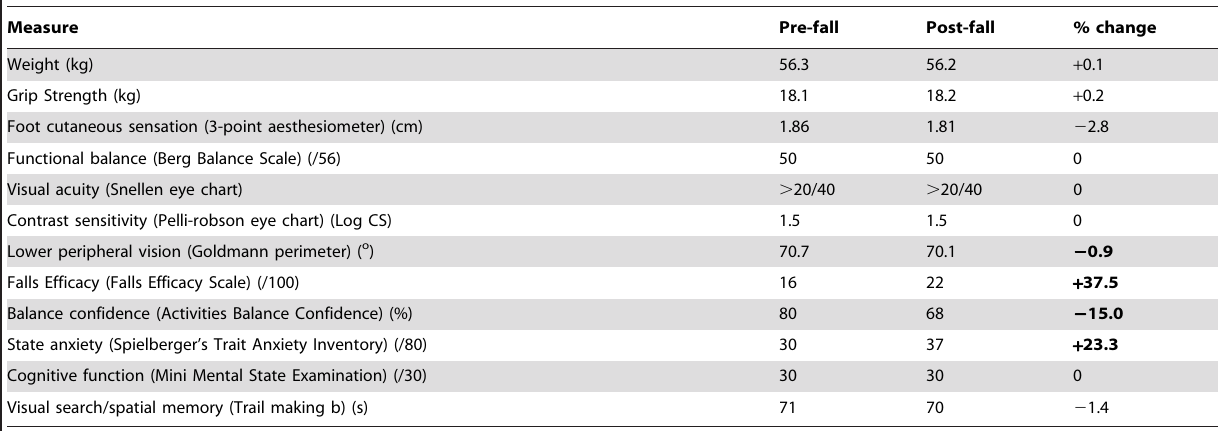
Table 1. Participant characteristics.